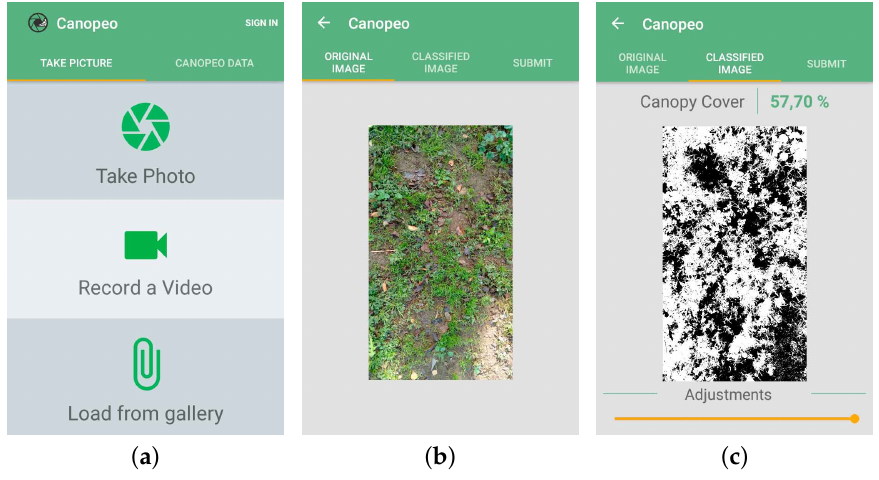
Figure 23. Canopeo: ( a ) Main menu; ( b ) Captured image visualization; ( c ) Image processing